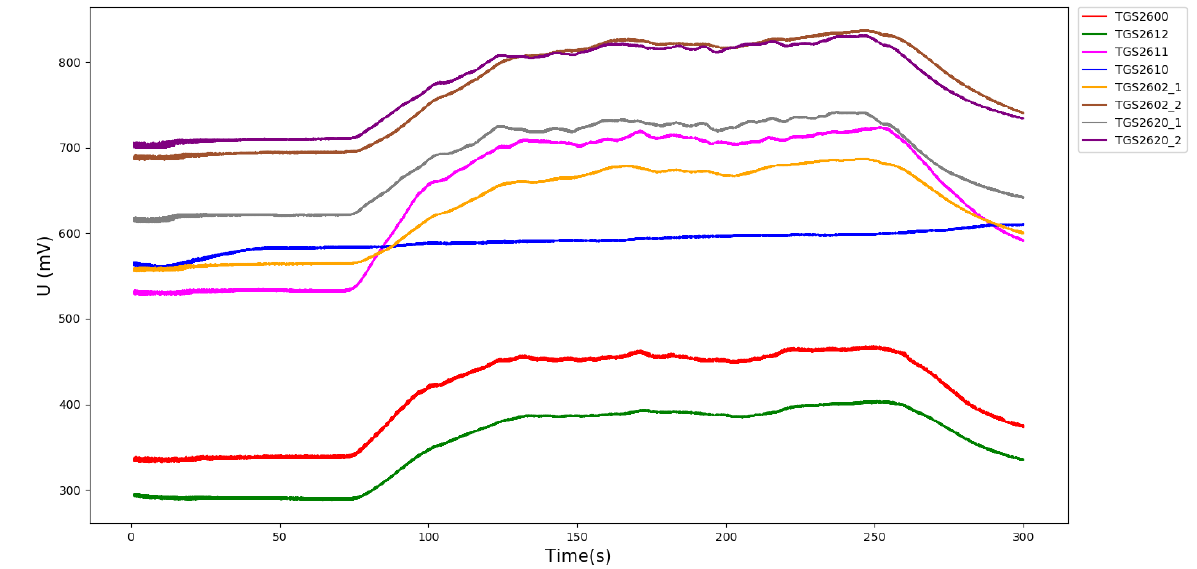
Figure 7. Sensor response graph under Et_L_Me_H